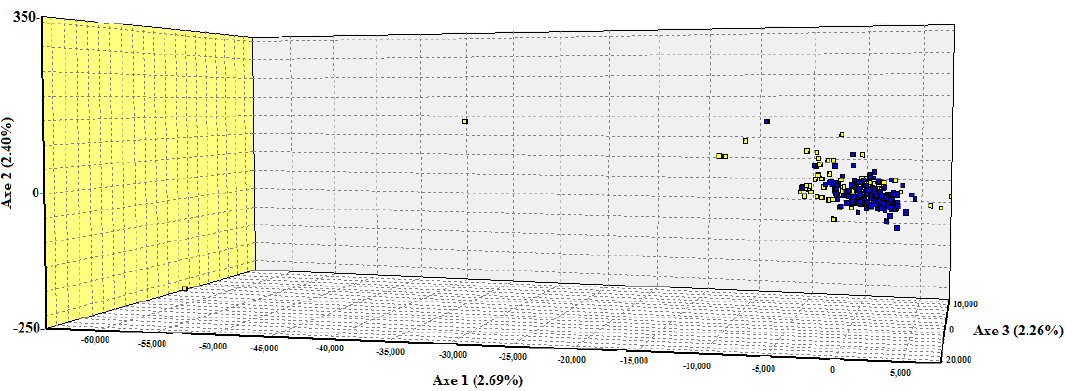
Figure 3. Factorial correspondence analysis between the Ch’aku and Q’ara subpopulations. Yellow, Ch’aku; Blue, Q’ara.